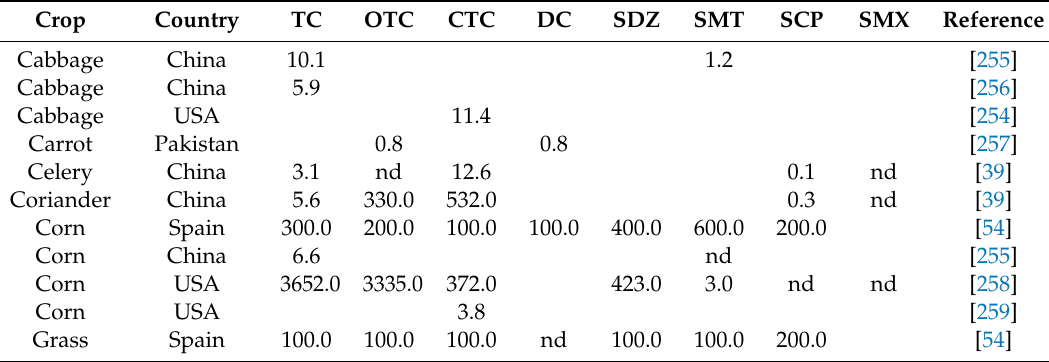
Table 12. Maximum concentration values ( µ g kg − 1 ) detected for di ff erent tetracycline and sulfonamide antibiotics in various